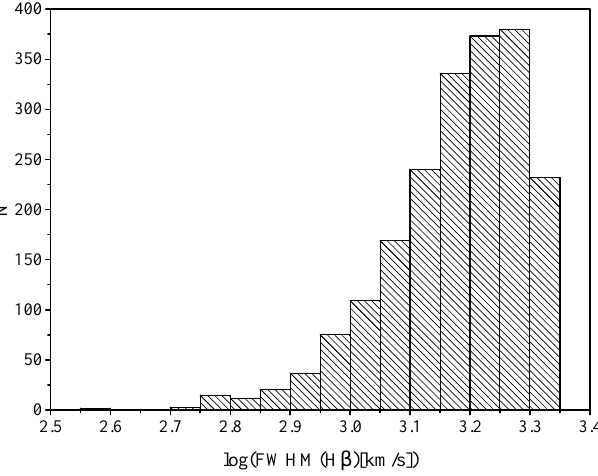
Figure 2. The distribution of FWHM (H β ) from the initial